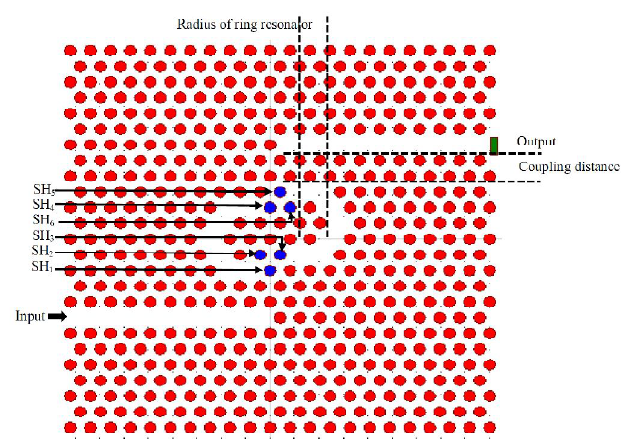
Fig.1. Sketchof the bio-sensor based on photonic crystal nano-ring resonator. Beneath the waveguide is the input and top of the waveguide is the output. The coupling distance, sensing holes, and the radius of ring resonator are marked on figure.